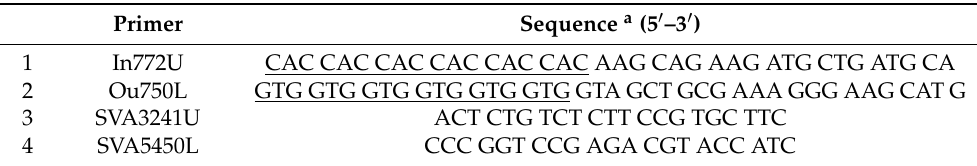
Table 1. Primers used for constructing pSVA-His. Primer Sequence a (5 (cid:48) –3 (cid:48)